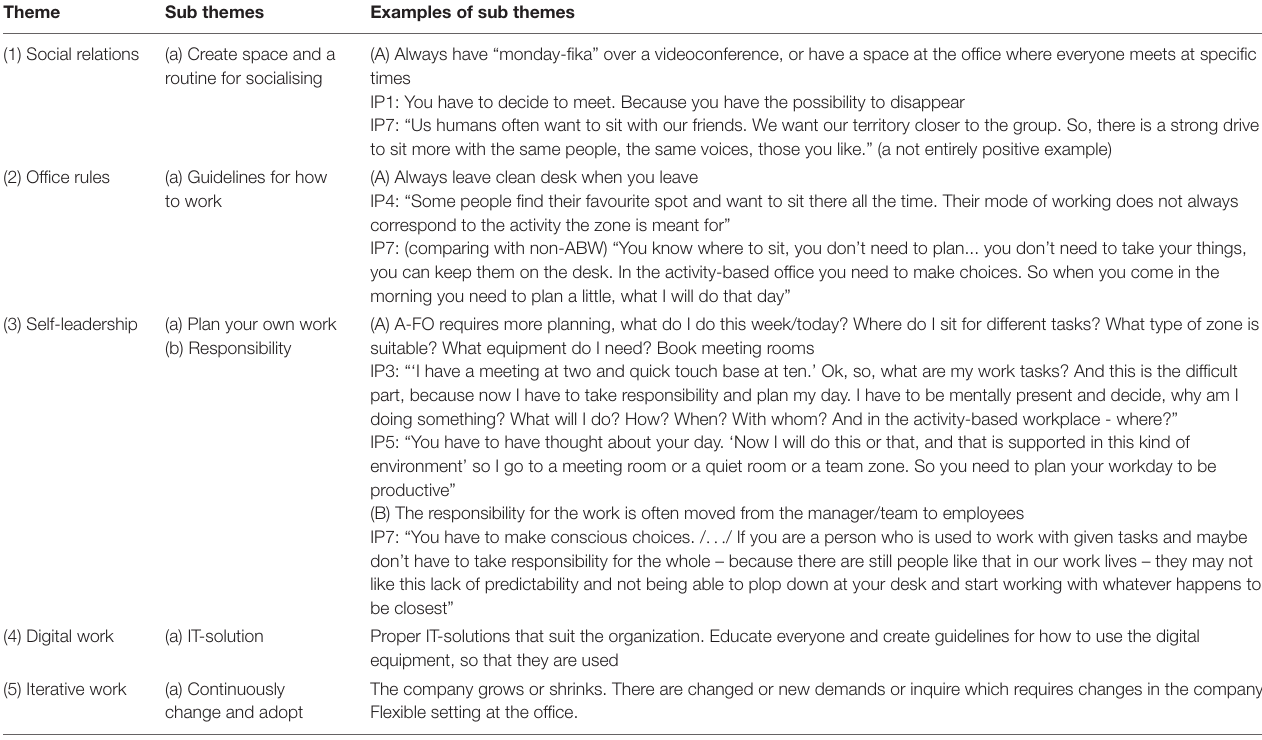
TABLE 1 | Subthemes and illustrative quotes for master theme II, Ways of Working, feeding into the activity-based working behaviors (ABW-B)